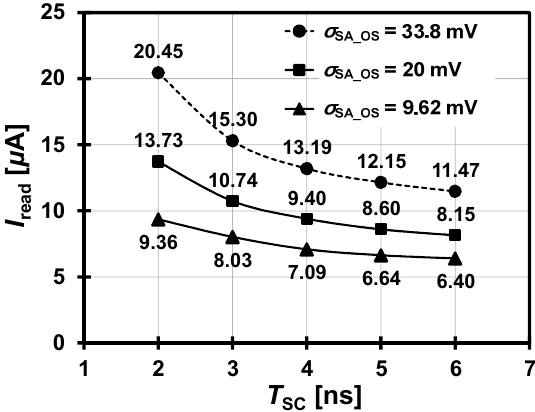
9 of 10 Figure 11. ( a ) Simplified layouts of DSTA-VLSA, FS-CLSA, and OCZS-SA. ( b ) Estimated array